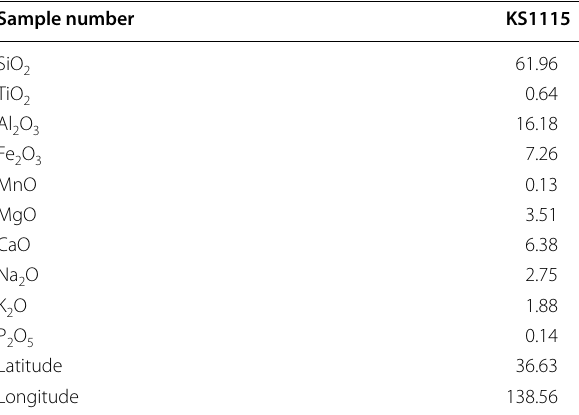
Table 1 Representative bulk composition of the Sessho